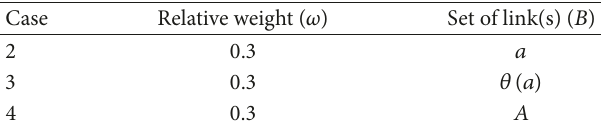
Table 5: Generalized path travel